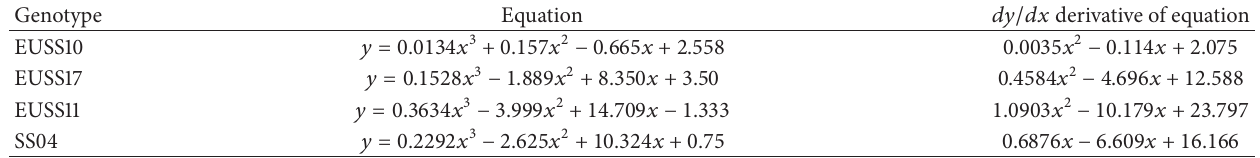
Table 2: Genotypes, equations, and first derivative of the functions for